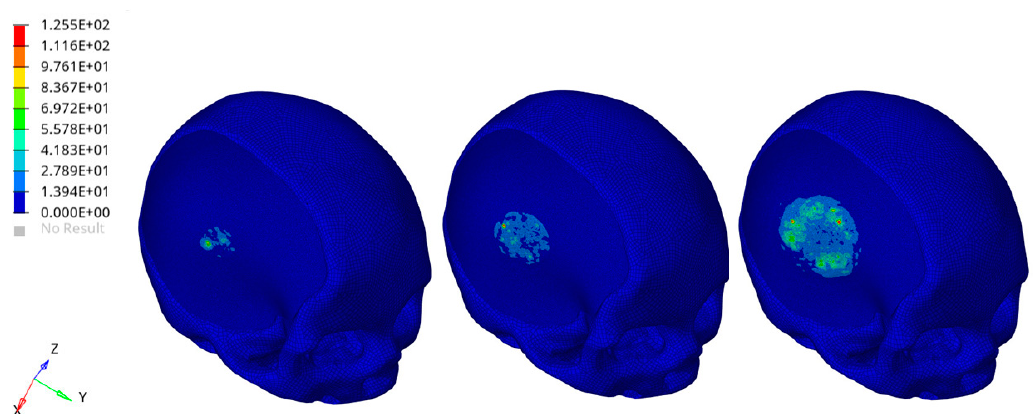
Figure 11. Biomechanical response as a result of the rigid sphere impacting the implant region of the head: von Mises stress (MPa) distributions for the external cement layer of the hybrid device at three different times after the initial impact ( left ). The figure is a guide for the eye to see the effect of the impact for the selected component. The color scale was chosen to allow for comparison among the models ad different times.